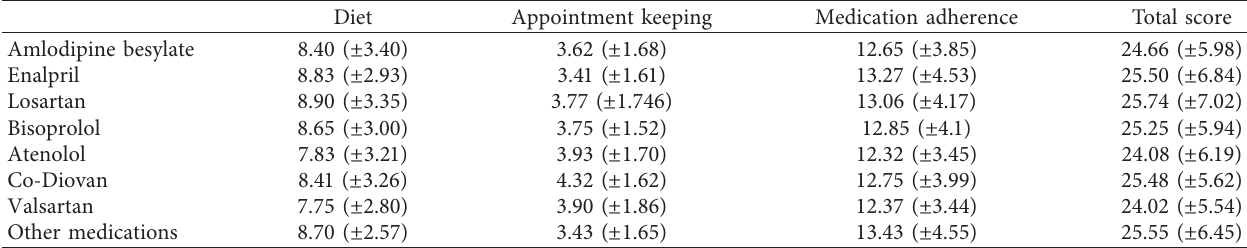
Table 7: Scores of the HILL-BONE CHBPTS and its subdomains according to the antihypertensive drug. Diet